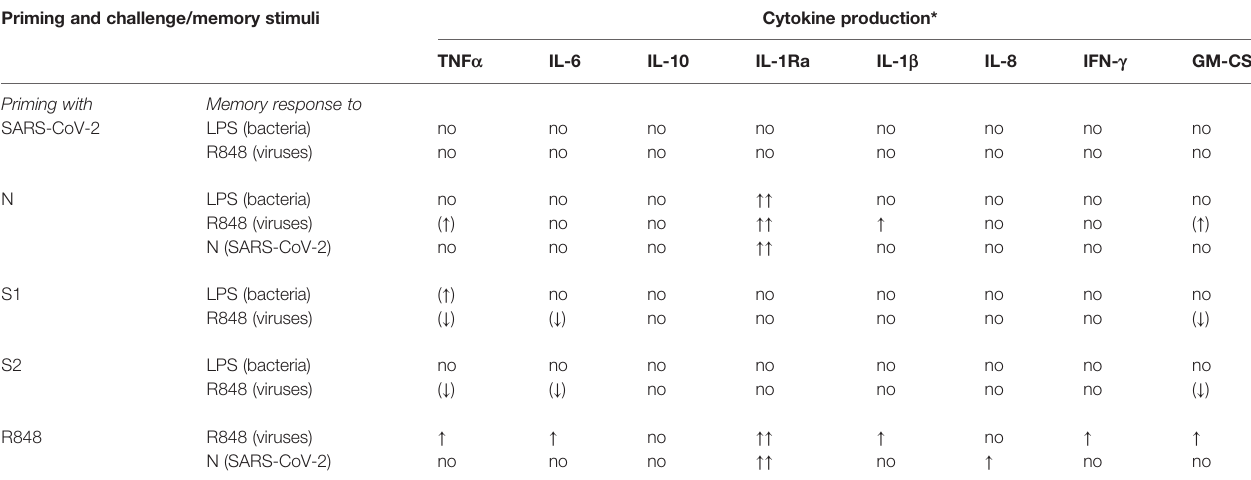
TABLE 1 | Summary of the capacity of SARS-CoV-2 and its proteins to induce innate memory in human monocytes. Priming and challenge/memory